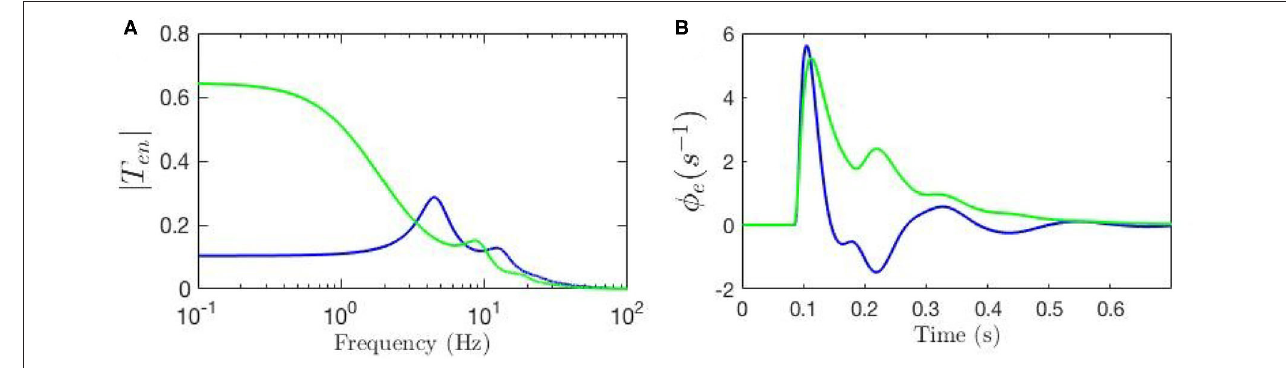
FIGURE 3 | Comparison of the frequency and time responses calculated for nominal parameter values for eye-open normal adults in resting state (green line) and in ERP event (blue line) from Table 1 . (A) Magnitude of the transfer functions. (B) Model cortical ERPs.